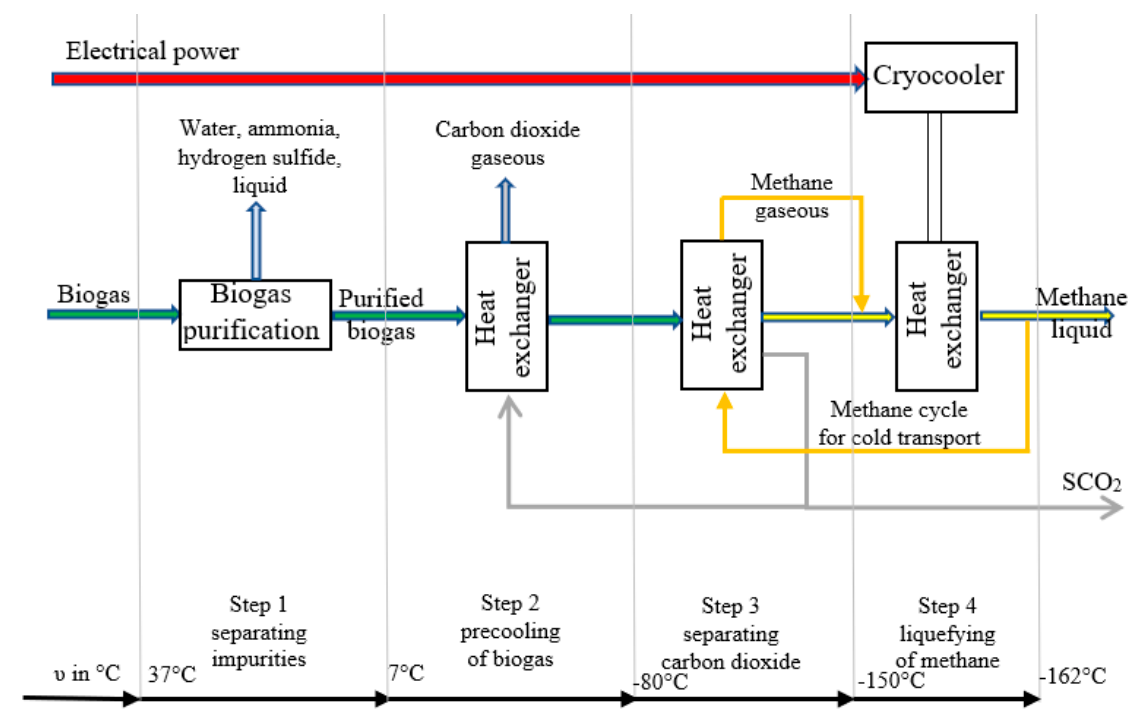
Figure 5. Biogas upgrading with concurrent SCO 2 and liquid biomethane production. SCO 2 —solid carbon dioxide.